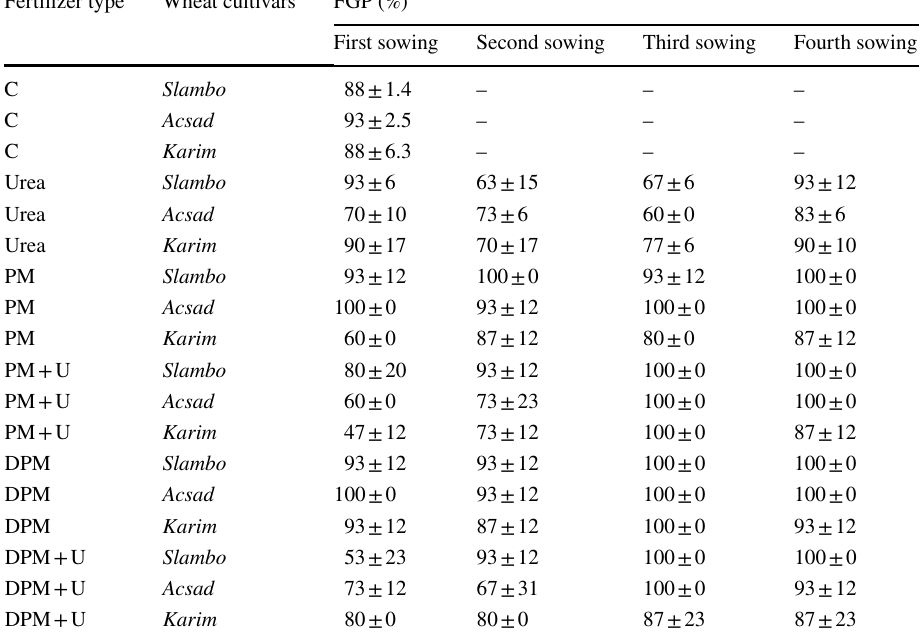
Table 5 Final germination percentage (FGP) of three wheat cultivars ( Slambo , Acsad and Karim ) after 14 days growing period sown in desert soil on four sowing dates after amendment with non-digested and anaerobically digested poultry manure with and without combination with